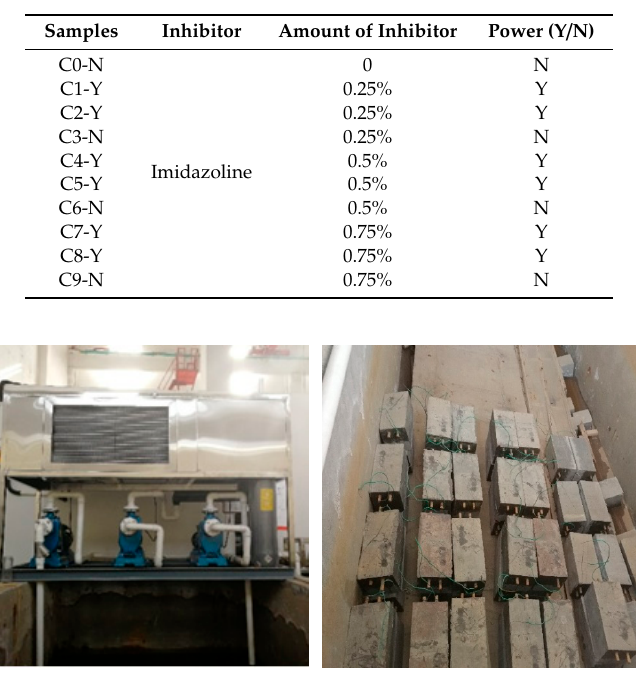
Table 4. Test setting of reinforced concrete.